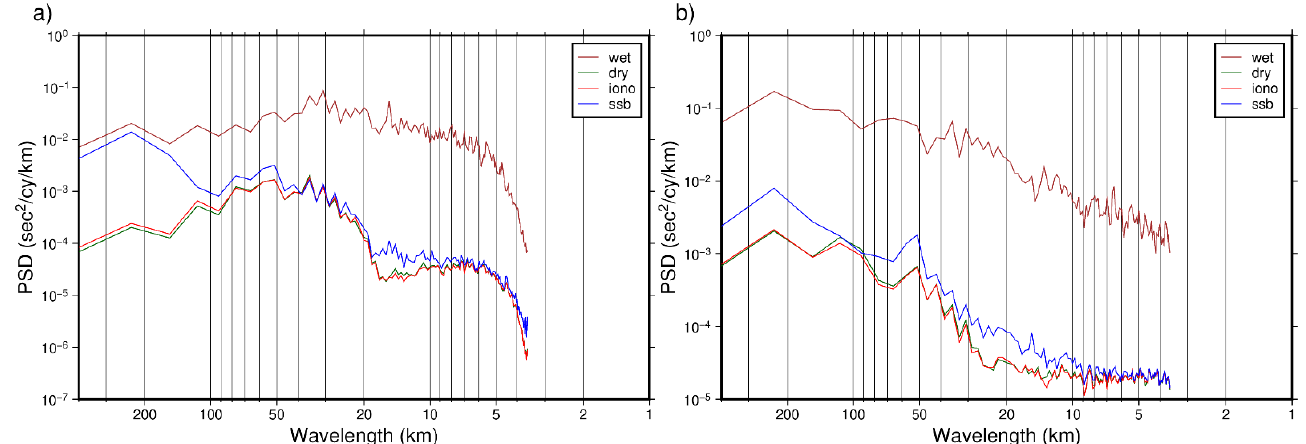
Figure 14. Error PSD of DV. ( a ) North-south component; ( b ) East-west component.